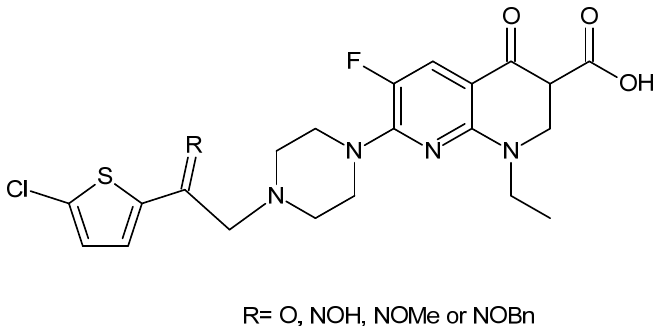
Figure 8. General structure of enoxacin derivatives prepared by Foroumadi et al. [88].